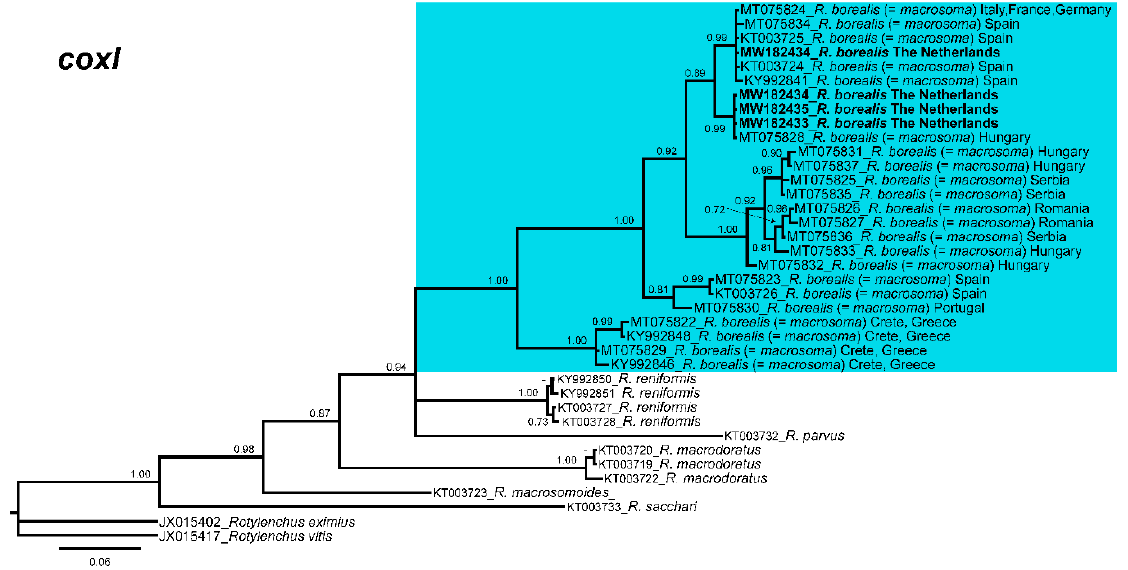
Figure 5. Phylogenetic relationships within the genus Rotylenchulus . Bayesian 50% majority rule consensus tree as inferred from coxI mitochondrial DNA (mtDNA) sequence alignment under the general time-reversible model of sequence evolution with correction for invariable sites and a gamma-shaped distribution (GTR + I + G). Posterior probabilities of more than 0.70 are given for appropriate clades. Newly obtained sequences in this study are shown in bold. Scale bar = expected changes per site.